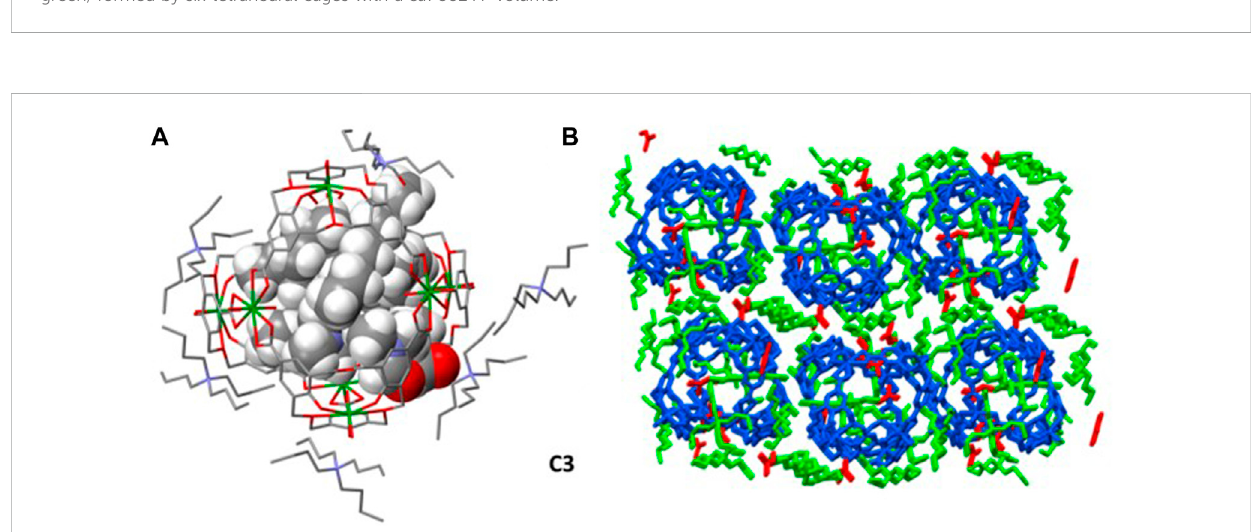
FIGURE 5 (A) Two TBAs and three DMFs fi lling the tetrahedral cage, whereas six TBAs surround the cage in C3 . (B) Packing of tetrahedral cages, TBA counterion, and DMF solvent